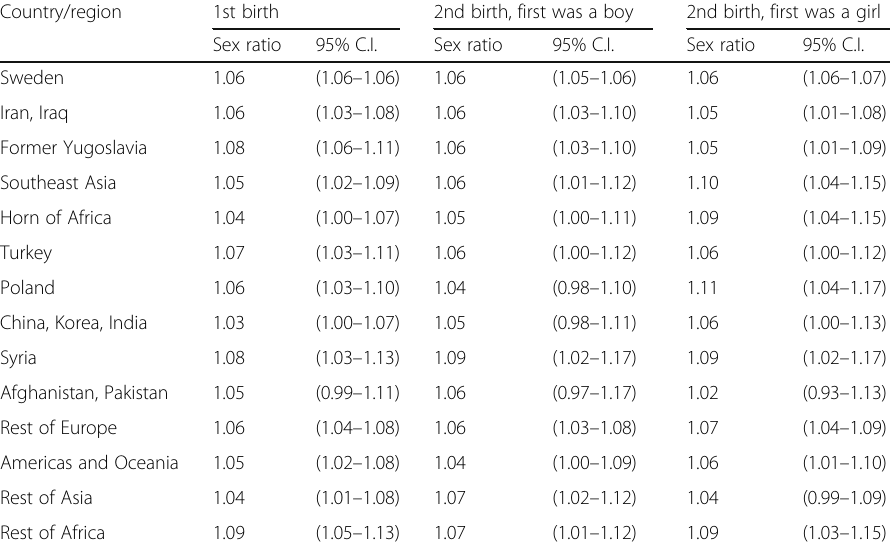
95% confidence intervals shown in parentheses. Source: Swedish population